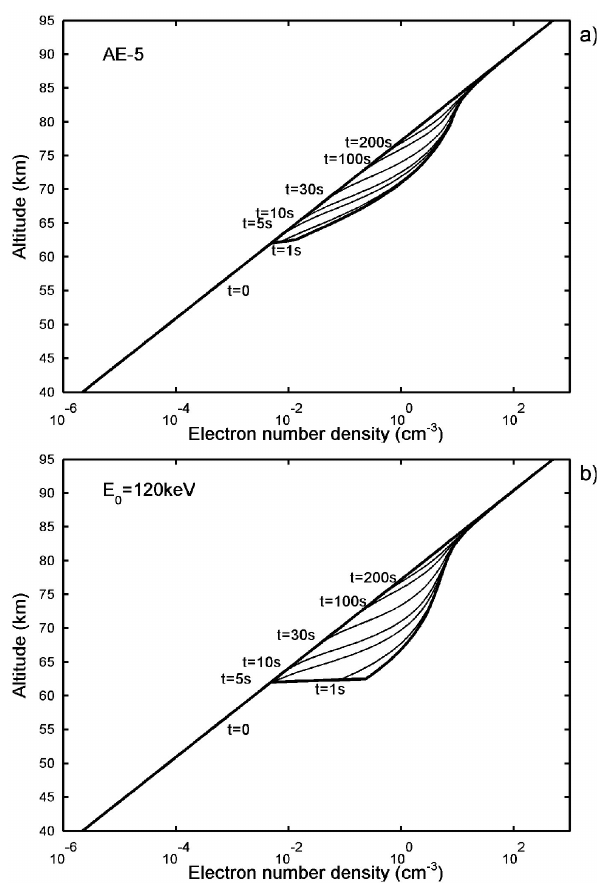
Fig. 3. Relaxation of different ionisation changes in the lower iono- sphere at various times after the creation of the WEP-produced patch. The initial change at t = 0, and the ambient night-time elec- tron density profile, are shown as heavy lines. (a) Ionisation pro- duced by the AE-5 WEP burst to the lower ionosphere. (b) Ionisa- tion due to the e -folding